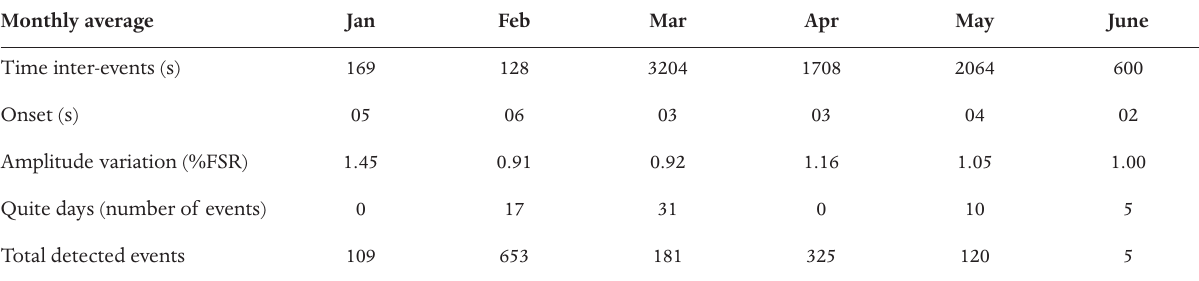
Table 1. Statistical properties of the VLF disturbance event analysis, January to June 2007. %FSR, percentage full scale